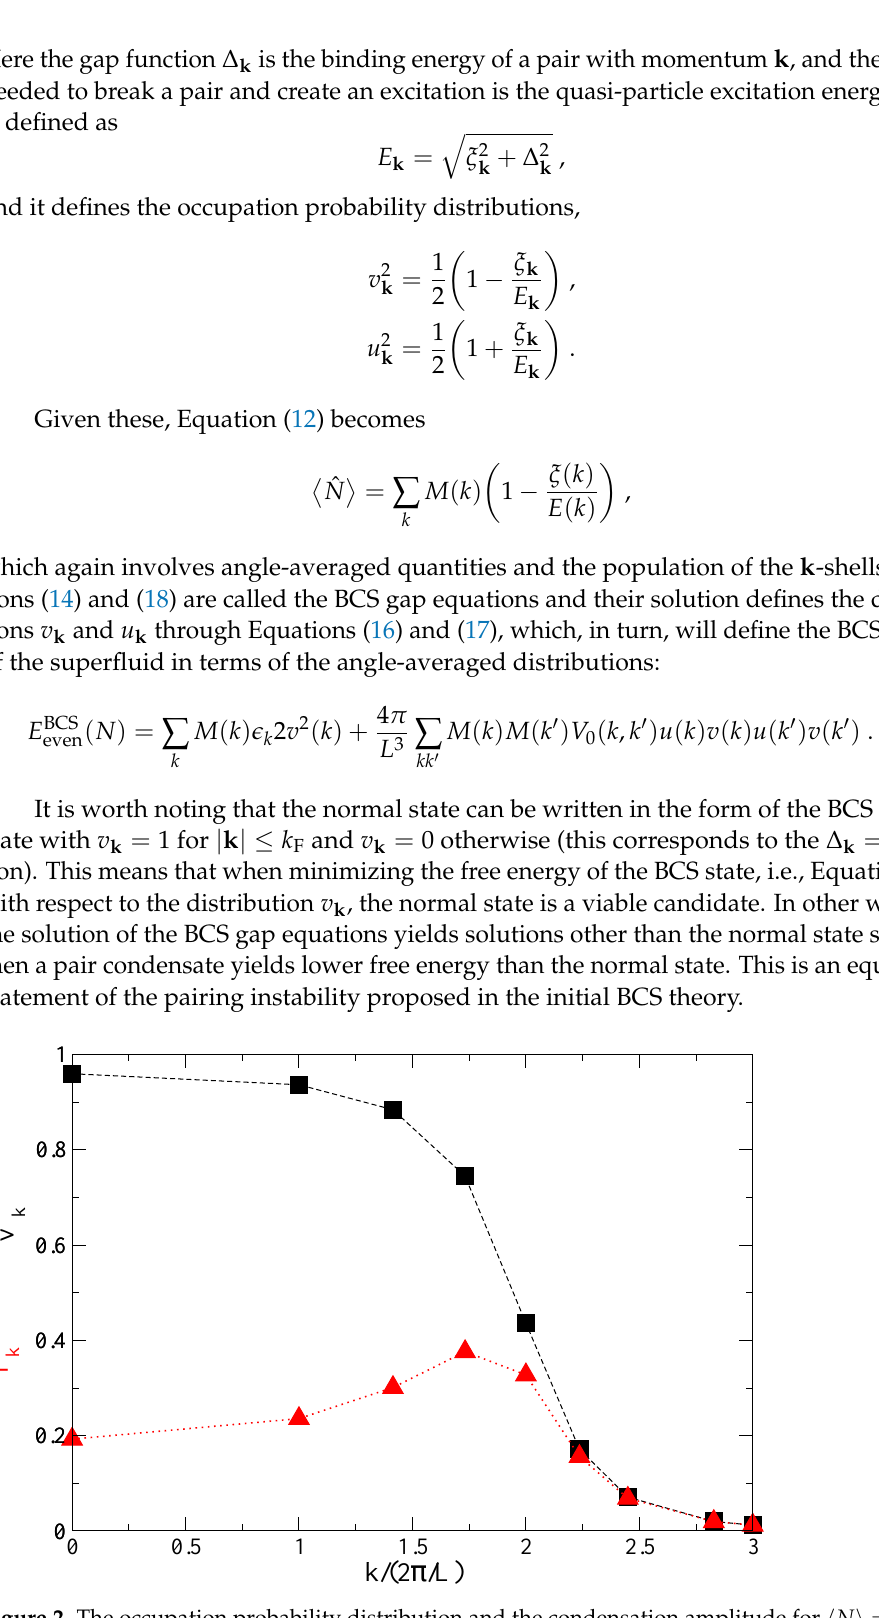
Figure 2. The occupation probability distribution and the condensation amplitude for (cid:104) N (cid:105) = 66 and k F a = −